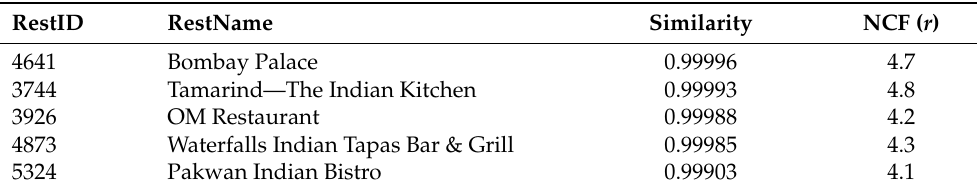
Table 11. NCF model results comparison, with the cosine similarity algorithm applied on GraphSAGE embedding, using the Neo4j GDS